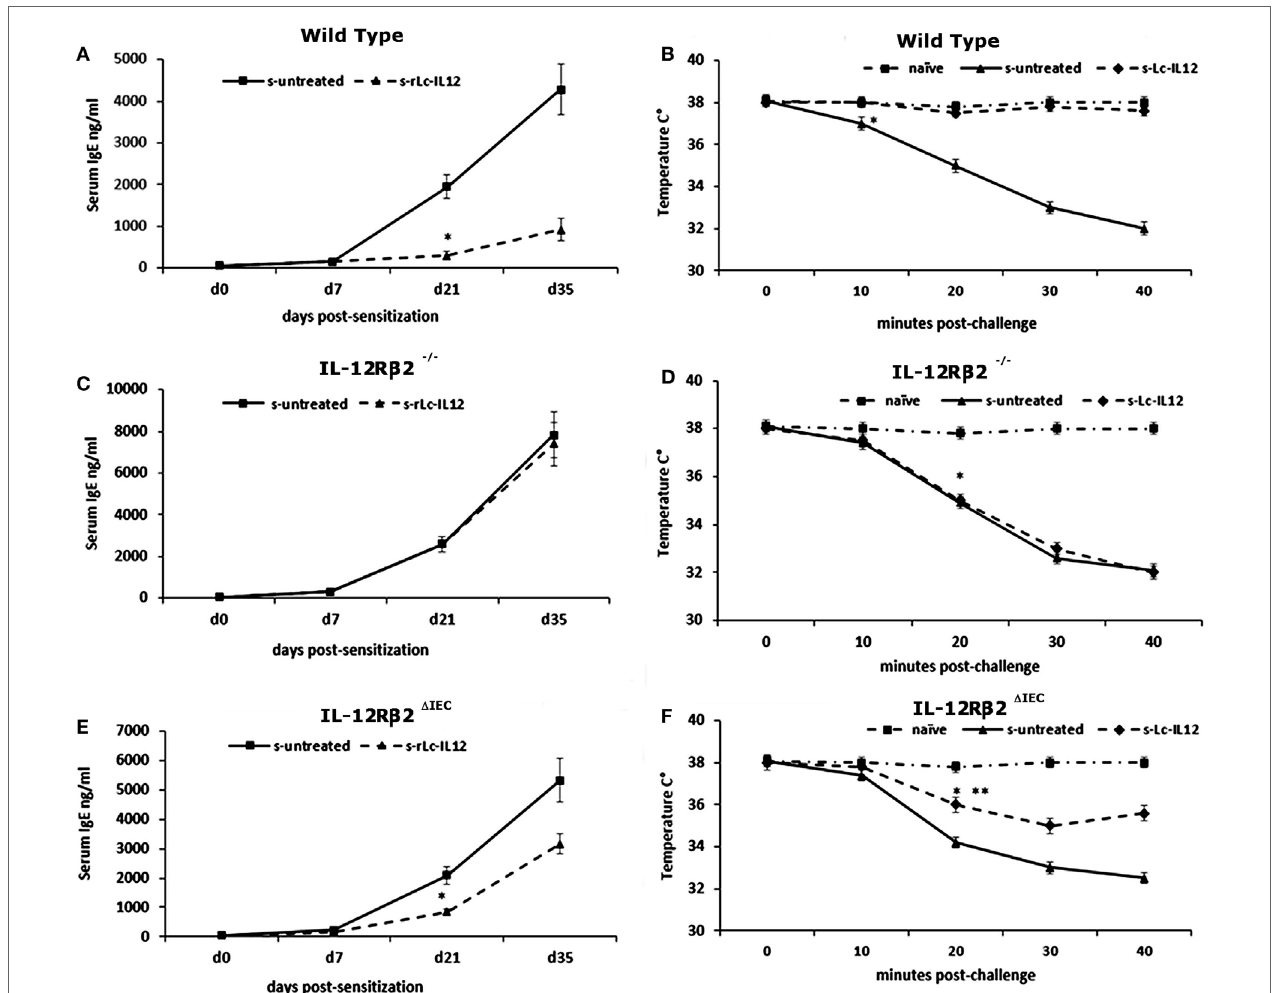
FigUre 5 | Effects of oral delivery of rLc-IL12 on IgE levels and body temperature in sensitized wild-type (wt) and chimeric mice. Administration of rLc-IL12 by oral gavage in a single dose to wt mice 24 and 2 h before administration of the sensitizing mixture significantly reduced the levels of allergen (peanut)-specific IgE antibody (a) and prevented the drop of the body temperature as assessed by rectal probe (B) showing that oral delivery of IL-12 via a genetically engineered strain of Lactococcu lactis could suppress food allergic reaction by restoring appropriate levels of IL-12. By contrast, administration of IL-12 in chimeric IL12R β 2 − / − mice (BM transplant from IL-12R β 2 − / − → IL-12R β 2 − / − ) had no effect. Indeed, neither plasma levels of IgE nor body temperature were affected by treatment with rLc-IL12 (c,D) . The pattern was different in chimeric IL-12R β 2 ∆ IEC mice (BM transplant from WT → IL-12R β 2 − / − ) that lacked the IL-12R β 2 exclusively on intestinal epithelial cells (IECs) (e,F) . In these mice, oral delivery of rLc-IL12 afforded a reduced protection against food allergy. Administration of rLc-IL-12 significantly reduced plasma levels of IgE compared to rLc-IL12 untreated sensitized mice; however, the extent of the reduction was much less pronounced compared to what was observed in fully competent IL-12R β 2 mice. Similarly, oral administration of rLc-IL12 did not completely abolished the allergy-associated drop in body temperature although the drop was significantly (**) less pronounced compared to sensitized rLc-IL12 untreated mice. Statistical analysis (8–10 mice group) was carried out by (ANOVA) Wilcoxon rank test. (*, **) indicates statistical differences. p < 0.05.